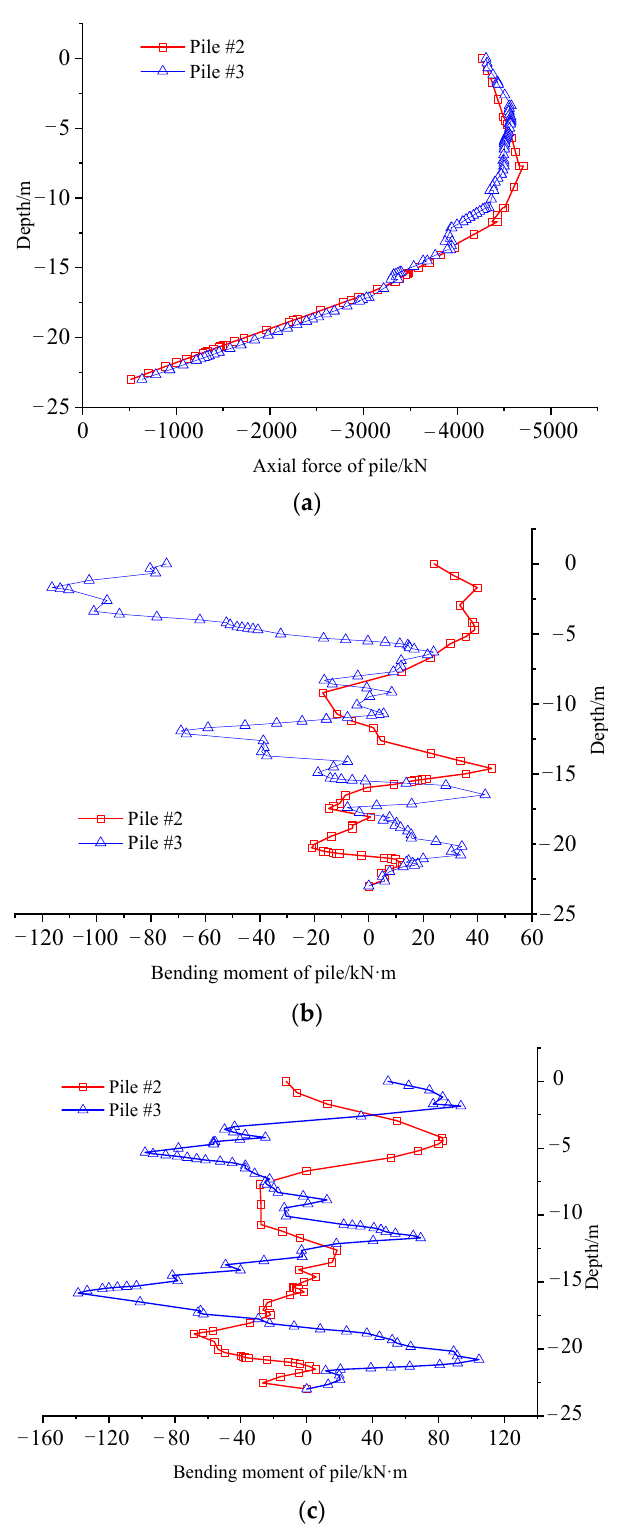
Figure 10. Internal forces in piles #2 and #3. ( a ) Axial force. ( b ) Bending moment parallel to tunnel direction. ( c ) Bending moment in vertical tunnel direction.